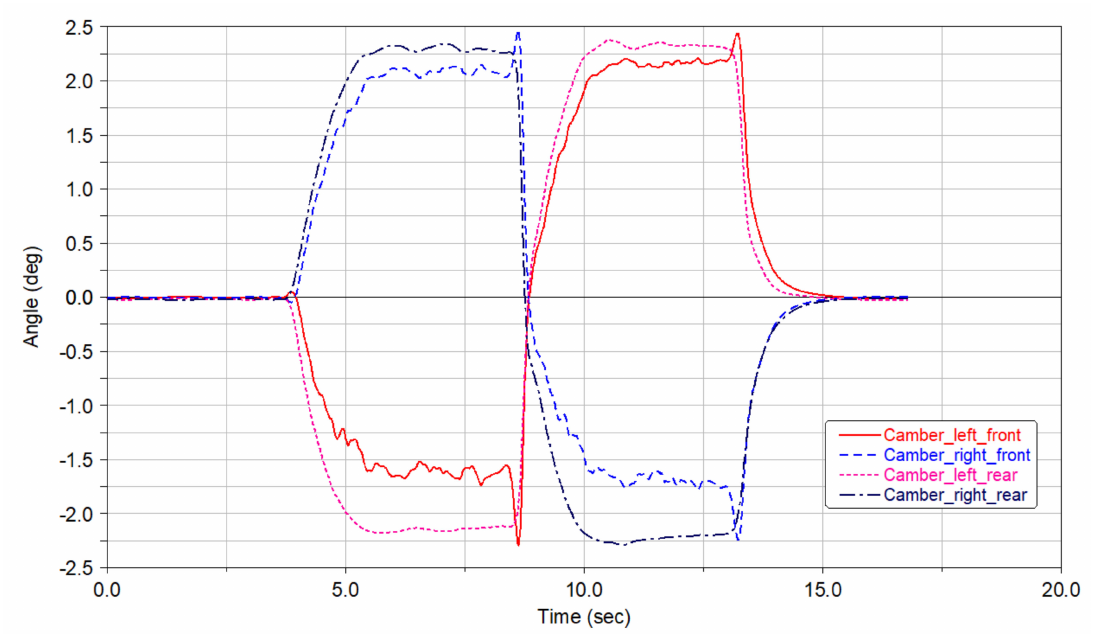
Figure 19. Skidpad Event-Tire camber angles, baseline